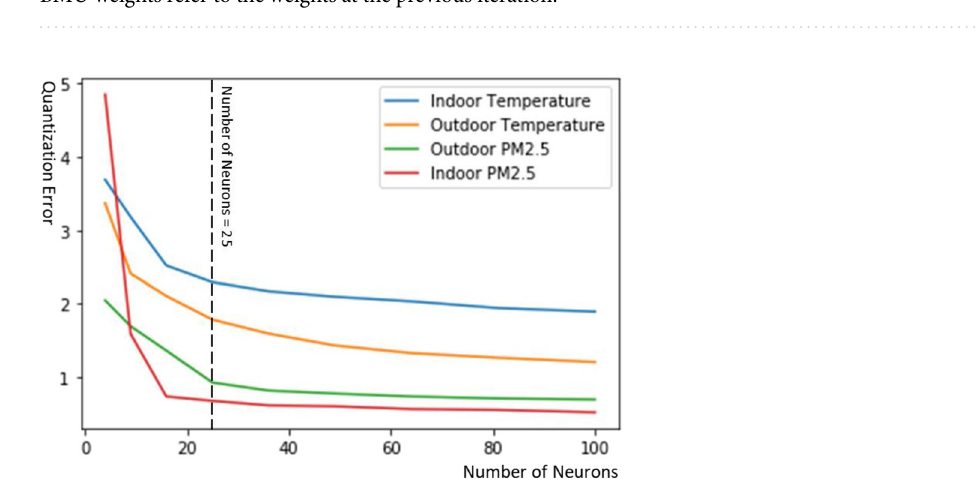
Figure 4. Visual comparison of the trained weights resulting from one iteration of the Euclidean training rule vs. the DTW training rule applied to a randomly selected observation from the 24-h outdoor temperature time series. Input data refers to the standard time series, trained weights refer to the weights after the iteration, and BMU weights refer to the weights at the previous iteration.